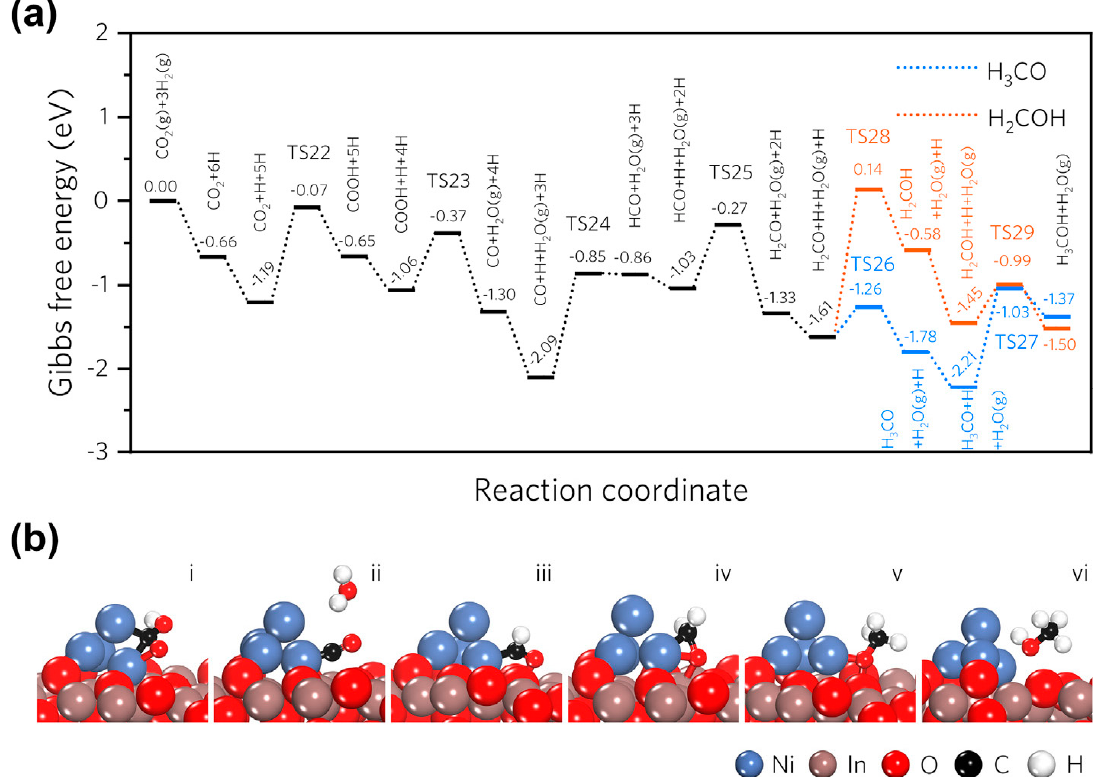
Figure 8. Catalytic mechanism investigation of methanol synthesis via RWGS pathway over Ni 4 /In 2 O 3 catalyst: ( a ) calculated Gibbs free energy pro fi le; ( b ) surface con fi gurations of Ni 4 /In 2 O 3 _D model at each elementary step. Reproduced with permission from ref. [96]. Copyright 2019 Elsevier.